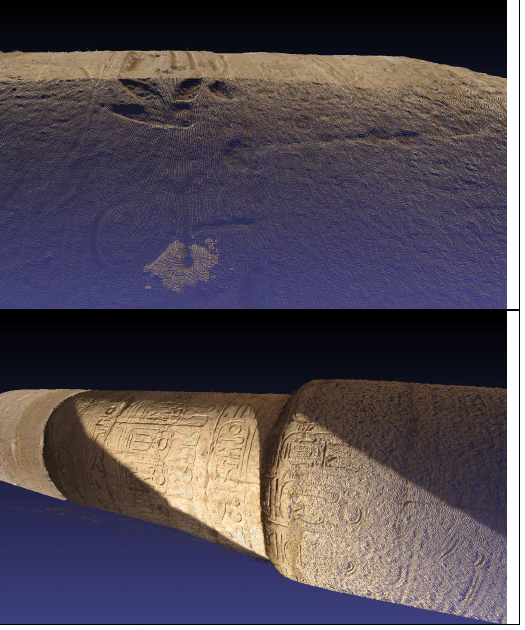
Figure 9. Two view of dense matching on the central colum of the Karnak temple data set.